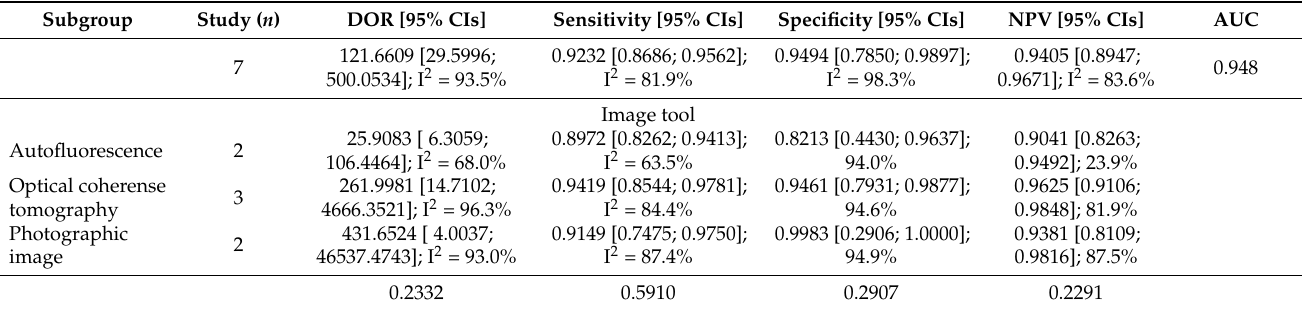
Table 2. Subgroup analysis regarding image tool in discriminating oral cancerous lesions from normal